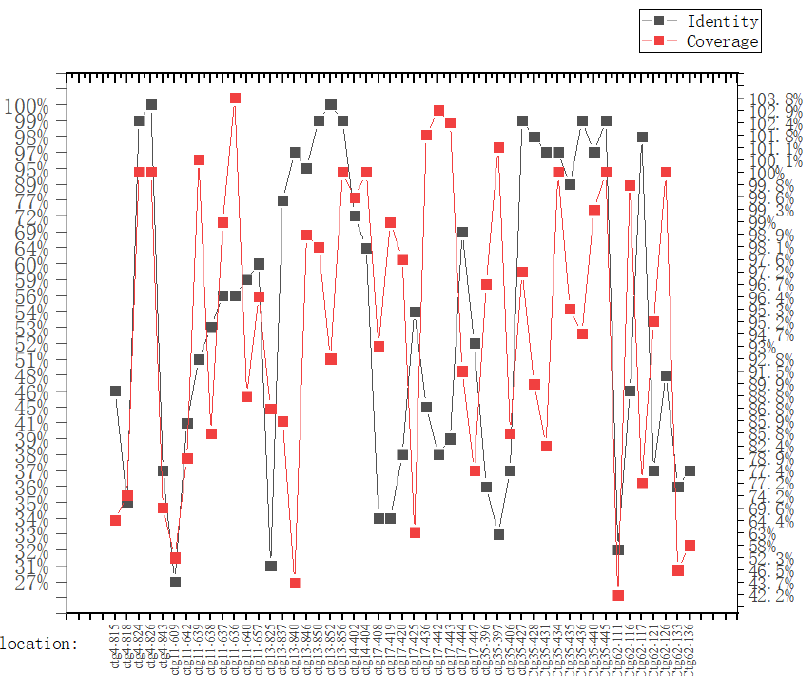
Figure 7. Gene location, identity and coverage of seven most similar BGCs in strain L14.